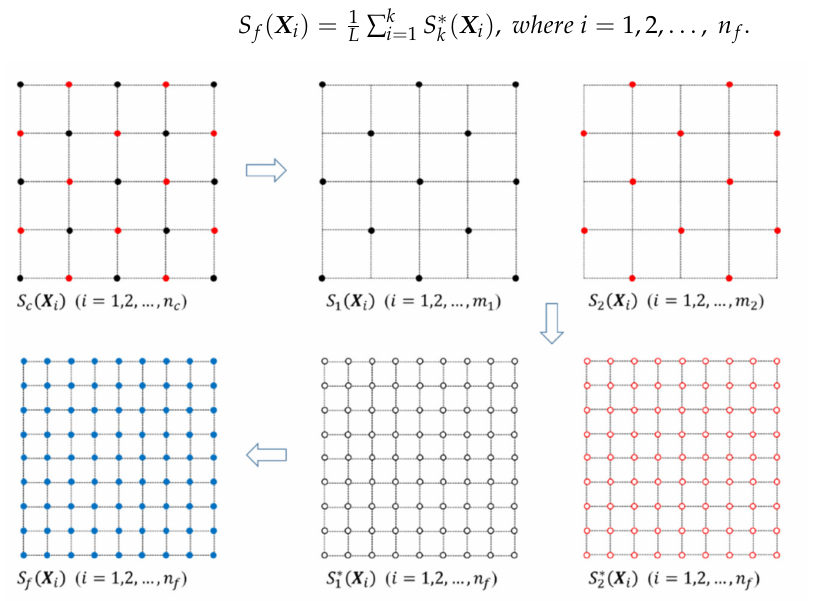
Figure 2. A partitioned radial basis function interpolation (PRBF) technique based on uniform sampling ( k =